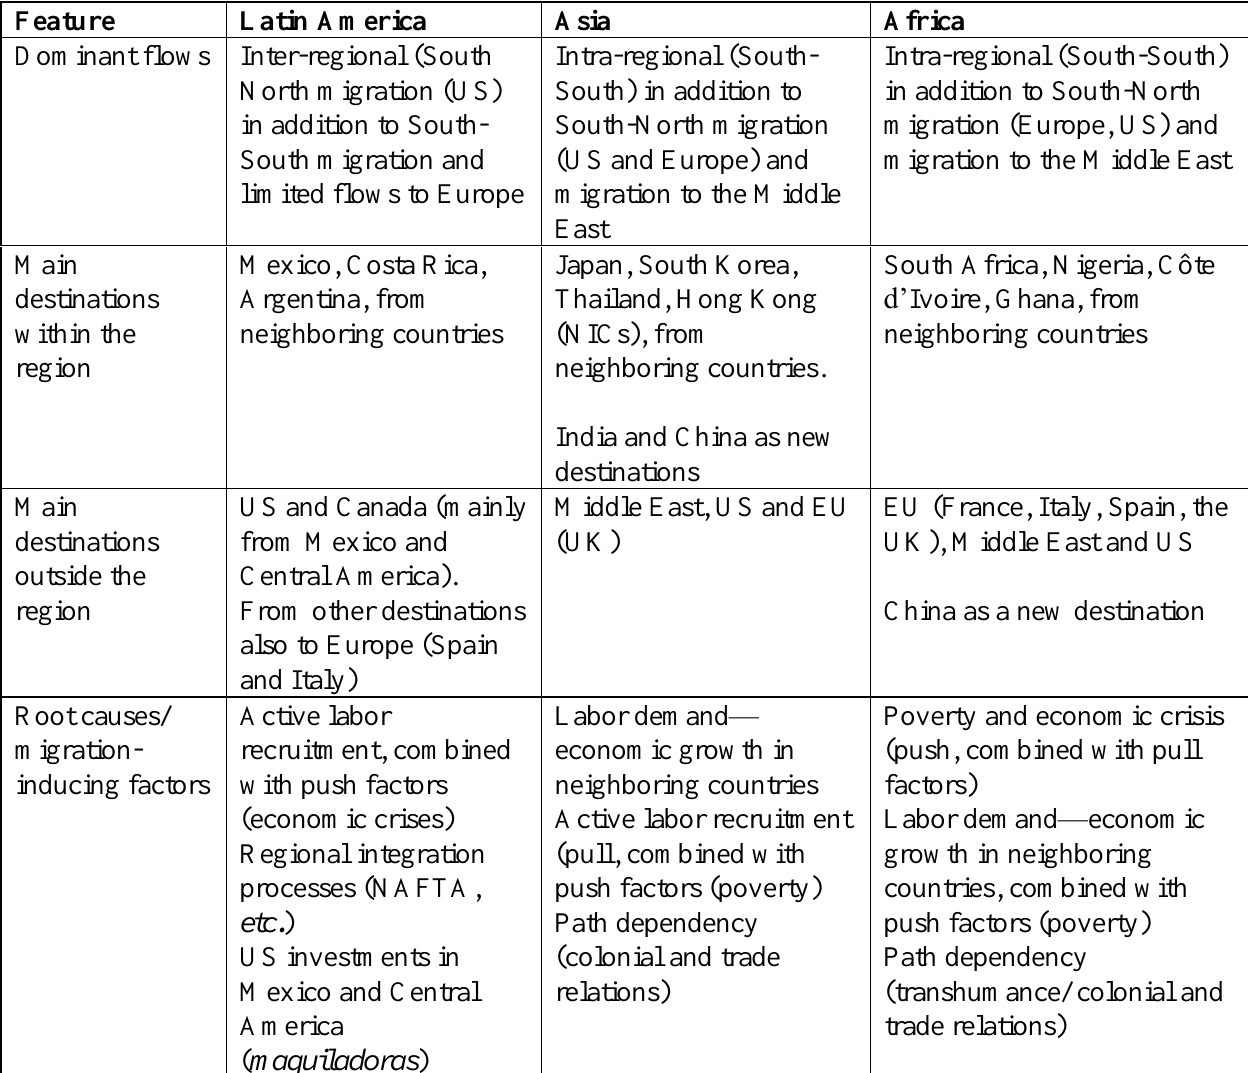
Table 1. The main features of migration in Latin America, Asia and Africa